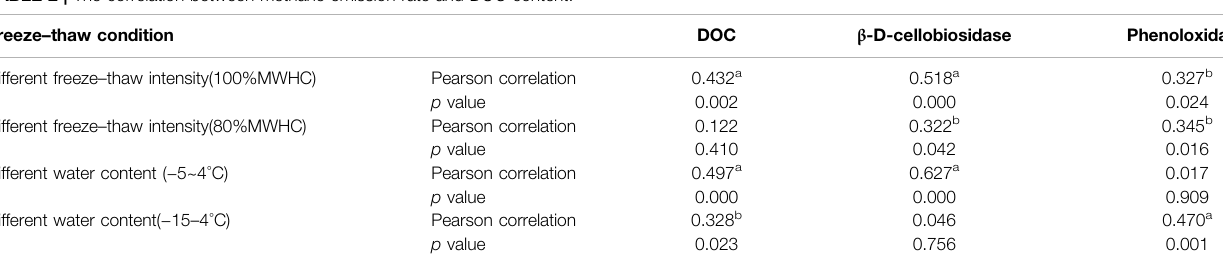
TABLE 2 | The correlation between methane emission rate and DOC